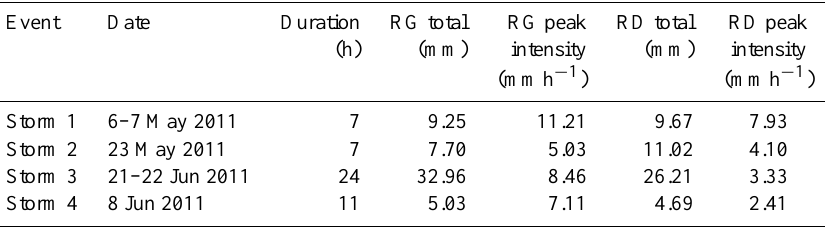
Table 1. Selected rainfall events over the Portobello catchment. Event